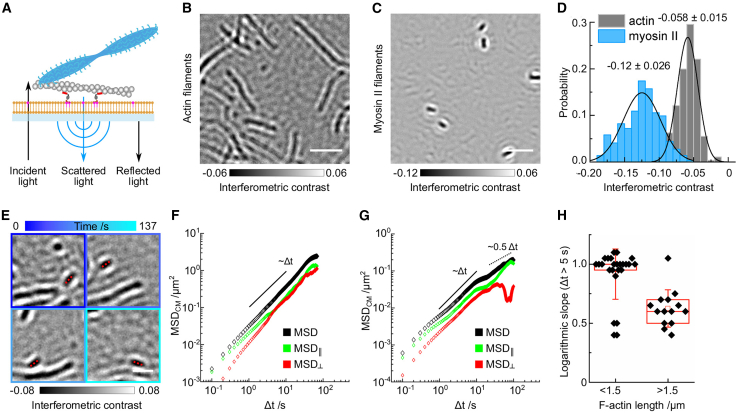
Experimental setup. (A) Shown is a diagram of the in vitro system consisting of a supported lipid bilayer (orange), actin-membrane linker protein decahistidine-KCK-ezrin actin binding domain (HKE; dark gray and red), actin filaments (gray), and muscle myosin II filaments (blue); arrows indicate principle of iSCAT microscopy. (B and C) Shown are example images of actin filaments (B) and myosin II filaments (C), both recorded with a 445-nm laser iSCAT system. Scale bars, 2 μm. (D) Shown is a histogram depicting the interferometric contrast distribution along actin filaments (gray, Nmeasure = 562 measurements along Nfil = 12 filaments) and myosin II filaments (blue, Nmeasure = 303 measurements along Nfil = 14 filaments); solid lines depict fits of a normal distribution with mean ± standard deviation noted above them. (E) Shown is an example of tracking a single actin filament (red dashed line, l = 0.4 μm) inside an actin network imaged over 137 s (from dark blue to cyan: 0–137 s; Video S3). Scale bars, 1 μm. (F) Shown is the corresponding MSD of the filament’s center of mass (black) and the components parallel (green) and perpendicular (red) to the actin filament orientation. (G) Shown is the MSD of the center of mass of a long actin filament (l = 4 μm, Video S4) (black) and its components parallel (green) and perpendicular (red) to the actin filament orientation, indicating confinement at timescales >10 s. (H) Shown is a box plot comparing the diffusive behavior (characterized by logarithmic slopes of MSD plots) of short (<1.5 μm, N = 25) and long (>1.5 μm, N = 14) actin filaments for Δt = 5 - 10 s indicating confined diffusion for filaments longer than 1.5 μm due to the surrounding actin meshwork, middle line: median, square: mean, whiskers: standard deviation. To see this figure in color, go online.